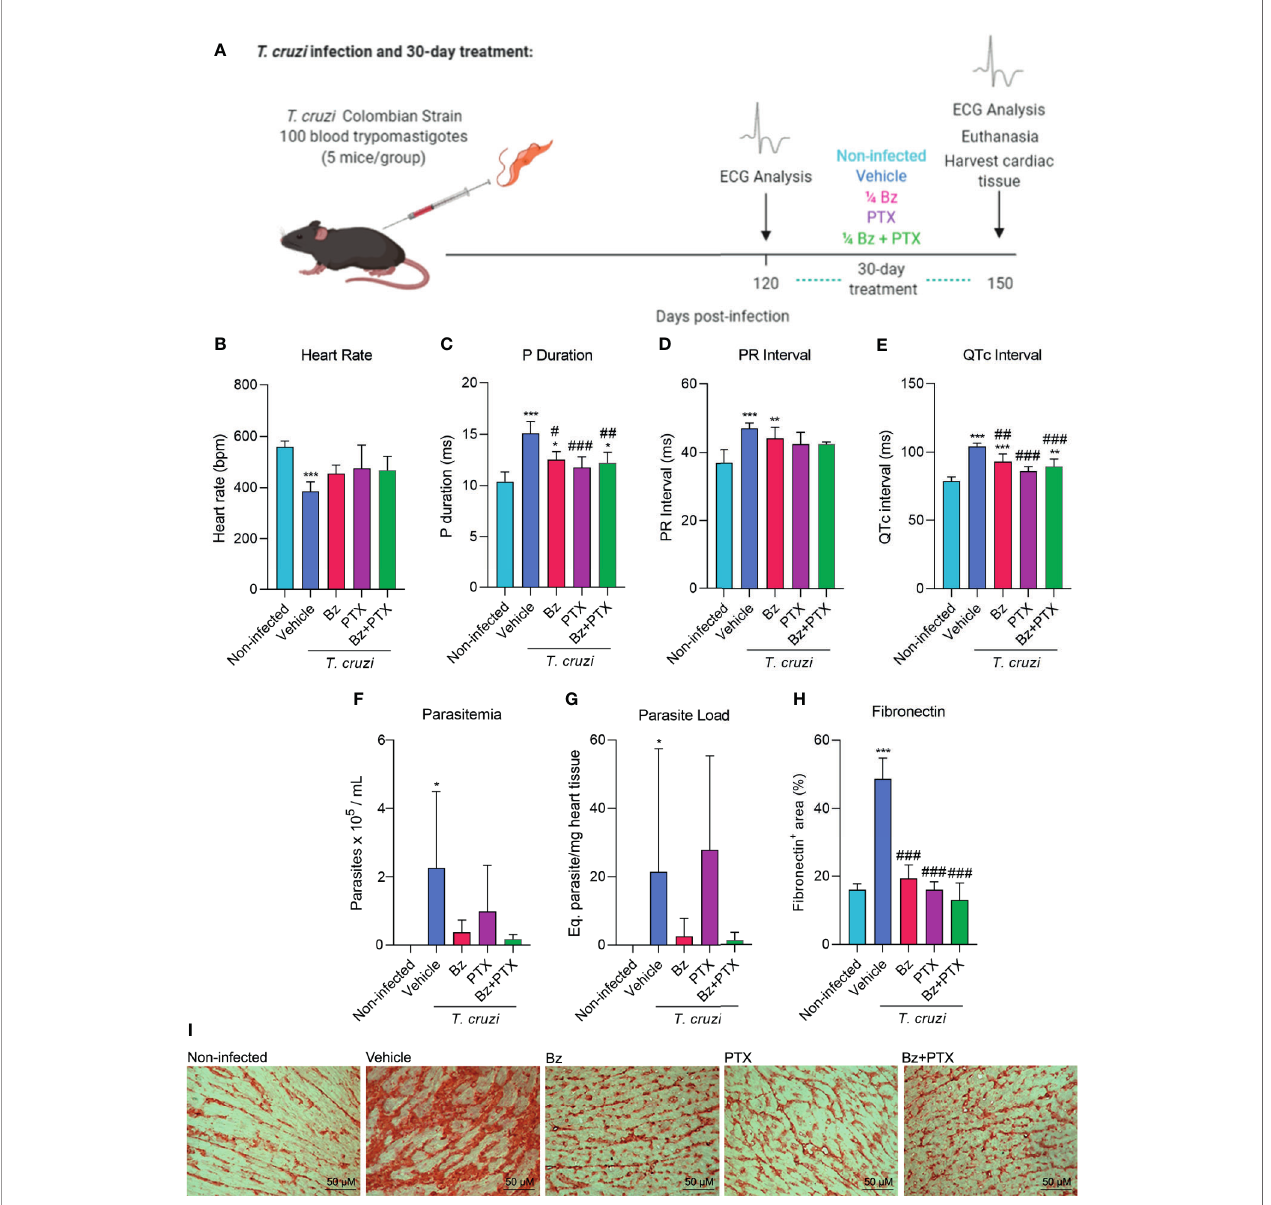
FIGURE 1 | Chronic Chagas cardiomyopathy model and treatment with suboptimal dose of benznidazole (Bz), pentoxifylline (PTX), or benznidazole and pentoxifylline (Bz + PTX). (A) Experimental design of infection and treatment. Mice were infected and treated daily from 120 to 150 dpi with vehicle, suboptimal dose of Bz (¼ dose, 25 mg/kg), PTX (20 mg/kg), a combined therapy of Bz+PTX and analyzed at 150 dpi. (B) Average heart rate ( vs . non-infected: vehicle: p = 0.001; Bz: p = 0.047). (C) Average P duration ( vs . non-infected: vehicle: p < 0.001; Bz: p = 0.021; vs . vehicle: Bz: p = 0.010; PTX: p < 0.001; Bz+PTX: p = 0.003). (D) Average PR interval ( vs . non-infected: Vehicle: p < 0.001; Bz: p = 0.008). (E) Average QTc interval ( vs . Non-infected: Vehicle: p < 0.001; Bz: p < 0.001; Bz+PTX p = 0.006; vs . vehicle: Bz: p = 0.008; PTX: p < 0.001; Bz+PTX: p < 0.001). (F) Parasitemia levels ( vs . non-infected: vehicle: p < 0.05). (G) Parasite load based on qPCR detection of T. cruzi satellite DNA on mice heart tissue ( vs . Non-infected: Vehicle: p < 0.05). (H) Percentage of fi bronectin+ area ( vs . non-infected: vehicle: p < 0.001; vs . vehicle: Bz: p < 0.001; Bz+PTX p < 0.001; Bz+PTX: p < 0.001). (I) Immunohistochemical staining of fi bronectin in the cardiac tissue. Number of mice per group: non-infected = 5; Vehicle = 4; Bz = 5; PTX = 5; Bz+PTX = 5. For all graphs, signi fi cance was determined using one-way ANOVA all pairwise multiple comparison vs . non-infected (*p < 0.05, **p < 0.01, ***p < 0.001) and vs . Vehicle ( # p < 0.05, ## p < 0.01, ### p <